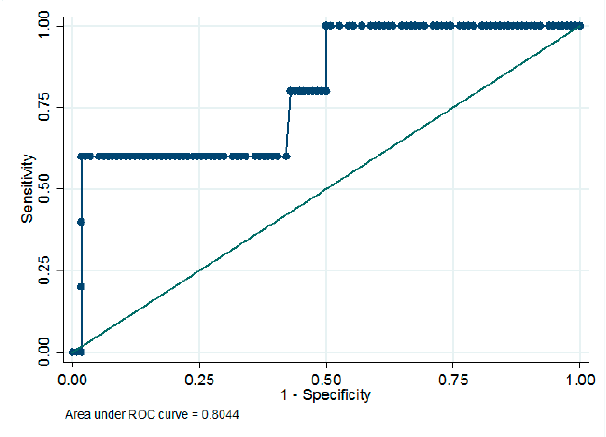
Figure 2. Prediction model of worsening of IT (increase of > 2 SDs at the end of follow-up) based on the increase of serum CML levels during the first year of follow-up. AU: 0.804 (95% CI: 0.585–1). AU: arbitray units.